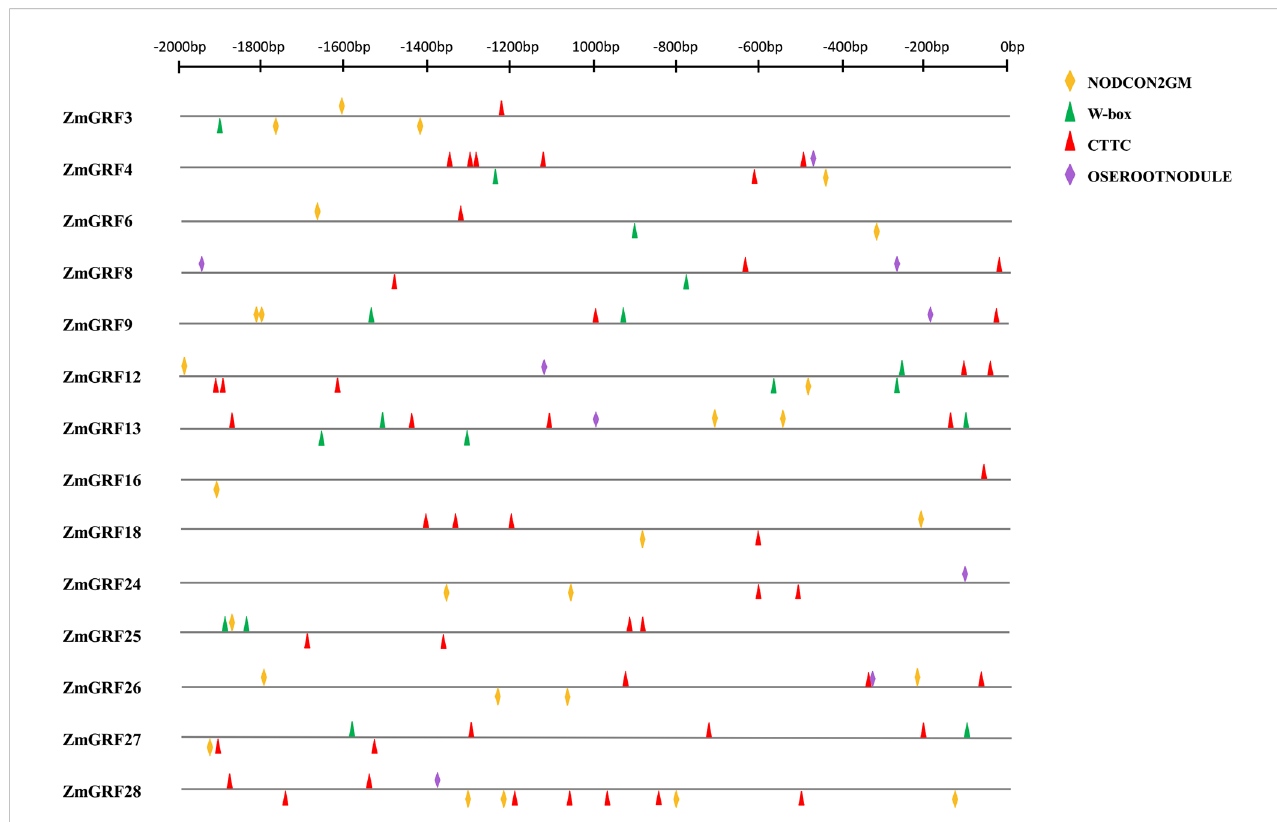
FIGURE 8 Promoter cis-acting element analysis. The promoter fragments are 2.0 kb in length. The yellow block represents the NODCON2GM motif. The green block represents the W-box motif. The red block represents the CTTC motif. The purple block represents the OSEROOTNODULE